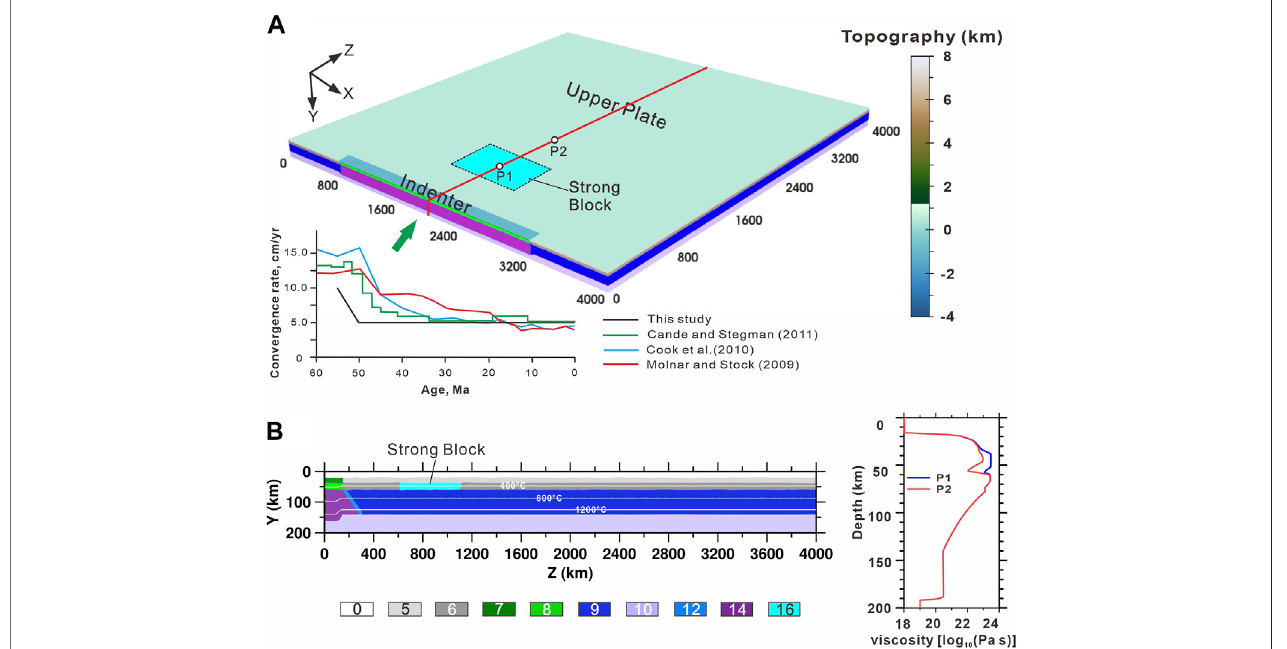
FIGURE3| Modelsetup. (A) the3Dmodeldomain(4,000×200×4,000 km).Thecolorscoveringthetopofthemodelindicatethemagnitudeofthetopographyas shown in the vertical color bar. The cyan-colored area represents the strong basin. The left bottom chart shows the convergence rate applied in this study and previous estimates (Cande and Stegman; Copley et al., 2010; Molnar and Stock, 2009). (B) The composition fi eld along the section x = 2000 km, as denoted by the red line in Figure 2A . And viscosity contrast between strong basin and surrounding areas whose localities are shown as P1 and P2 in (A) . The blue curve represents the viscosity pro fi le of the strong basin, and the red curve represents the viscosity pro fi le of the surrounding areas. Composition numbers represent different rock types: 0- sticky air; 5- Asian upper crust; 6- Asian lower crust; 7- Indian upper crust; 8- Indian lower crust; 9- Asian lithospheric mantle; 10- asthenosphere; 12- weak zone; 14- Indian lithospheric mantle; and 16- strong lower crust of the